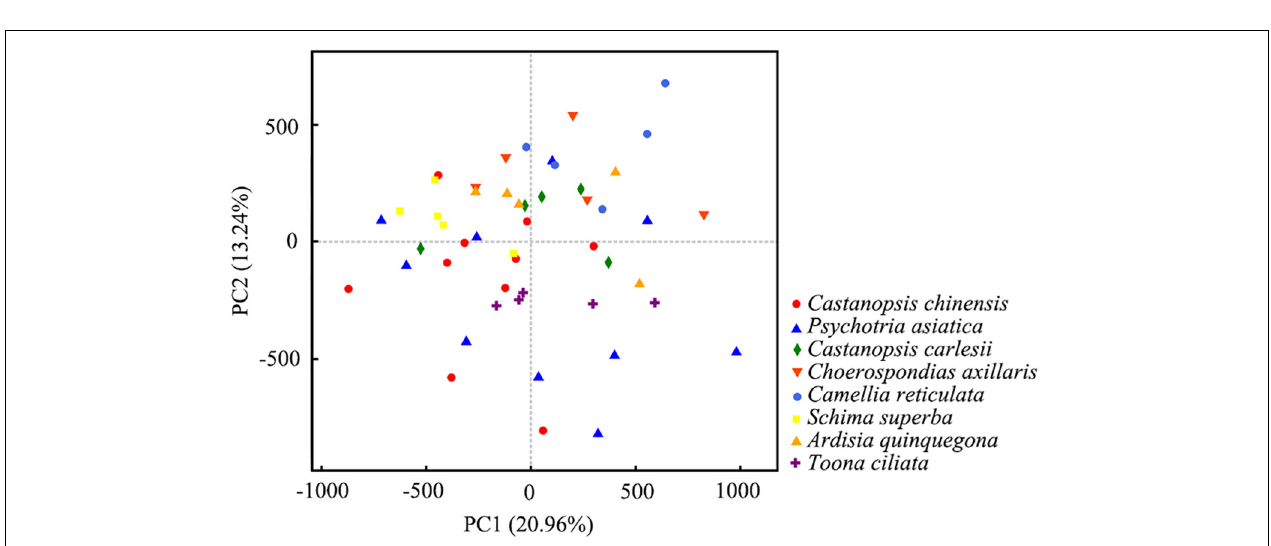
FIGURE 6 | Variation partition analysis (VPA) of soil/site properties on the bacterial community. (A) Mycosphere soil. (B) Bulk soil.